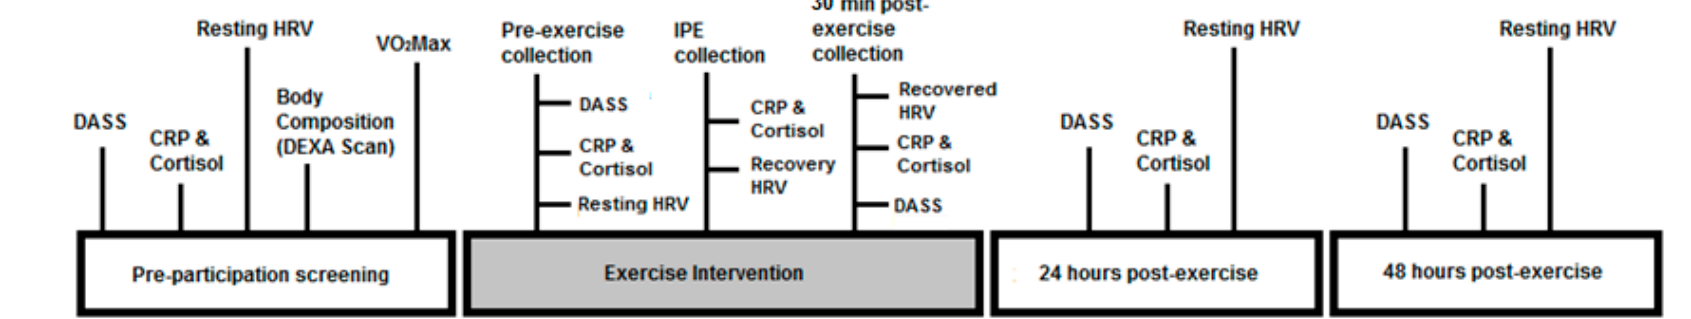
Figure 1. Study Timeline. Note: DASS: Depression, Anxiety and Stress Scale; CRP: C-reactive protein; HRV: heart rate variability, VO 2 max: maximum oxygen consumption: IPE: immediately post exercise.